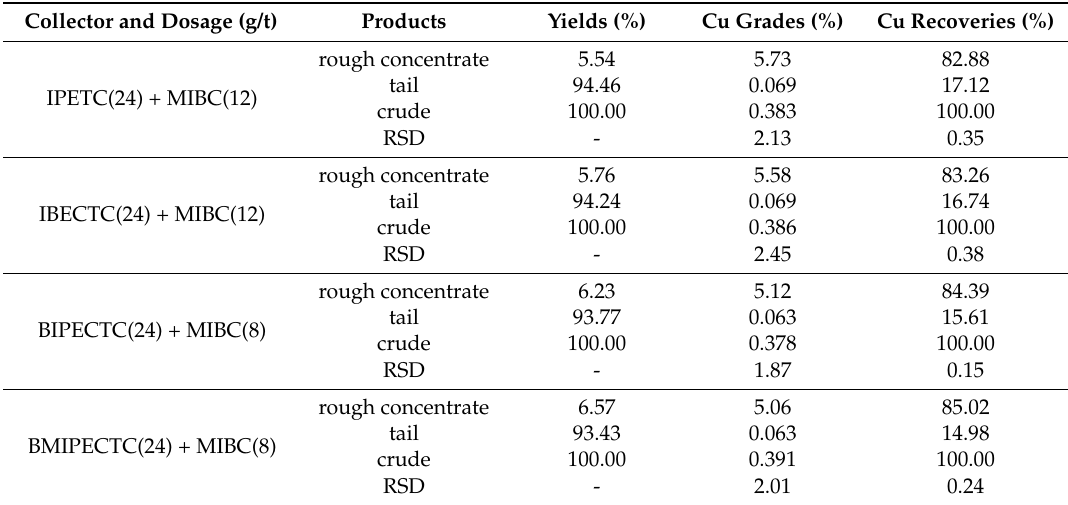
Table 3. Comparative Cu recoveries by IPETC, IBECTC and the synthesized